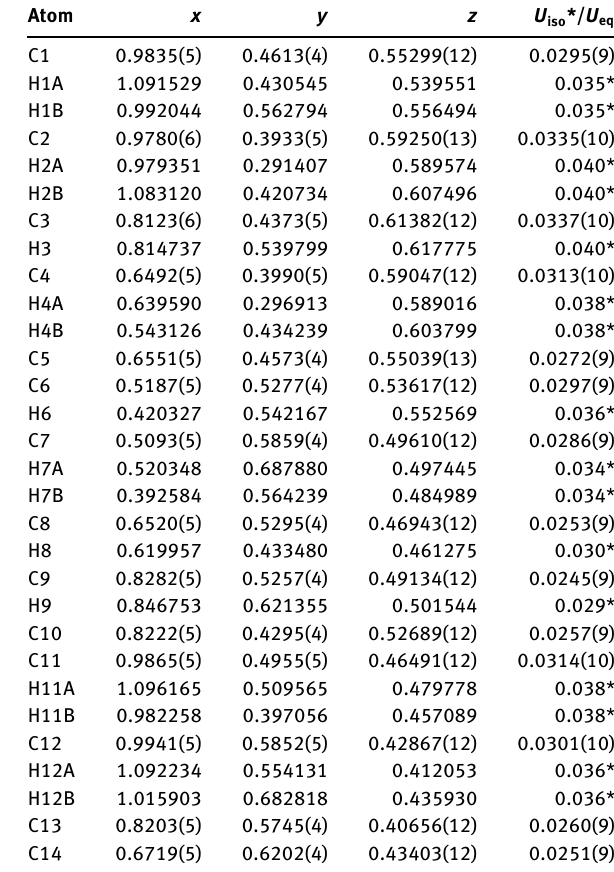
Table 2: Fractional atomic coordinates and isotropic or